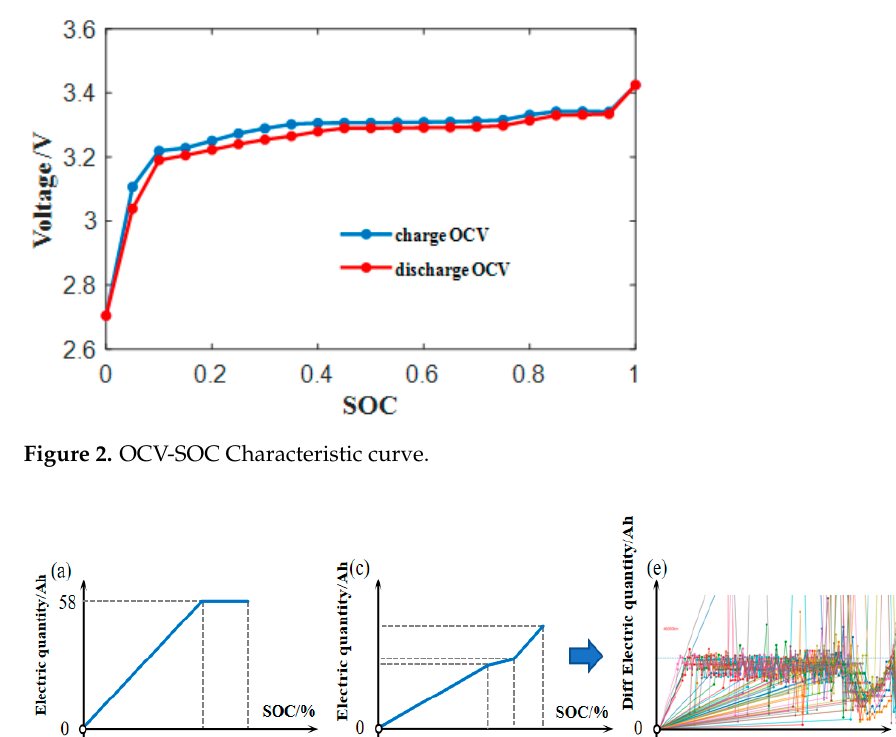
Figure 2. OCV-SOC Characteristic curve.